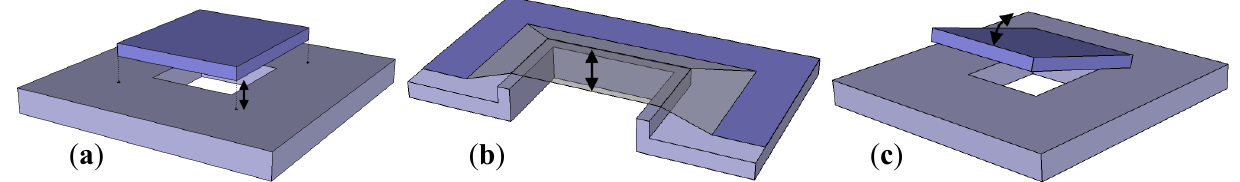
Figure 3. Schematic drawings of several microvalve design concepts. ( a ) Vertically translating plate; ( b ) Vertically translating membrane (cross-section); ( c ) Tilting plate; ( d ) Horizontally translating plate; ( e ) Bending plate; ( f ) Needle (planar); ( g )